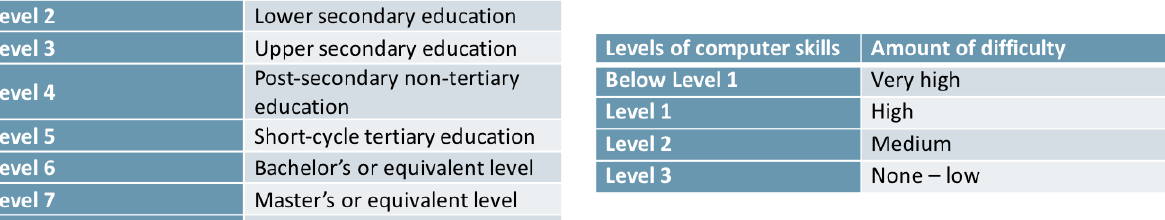
Table 7: Amount of diflculty related to computer